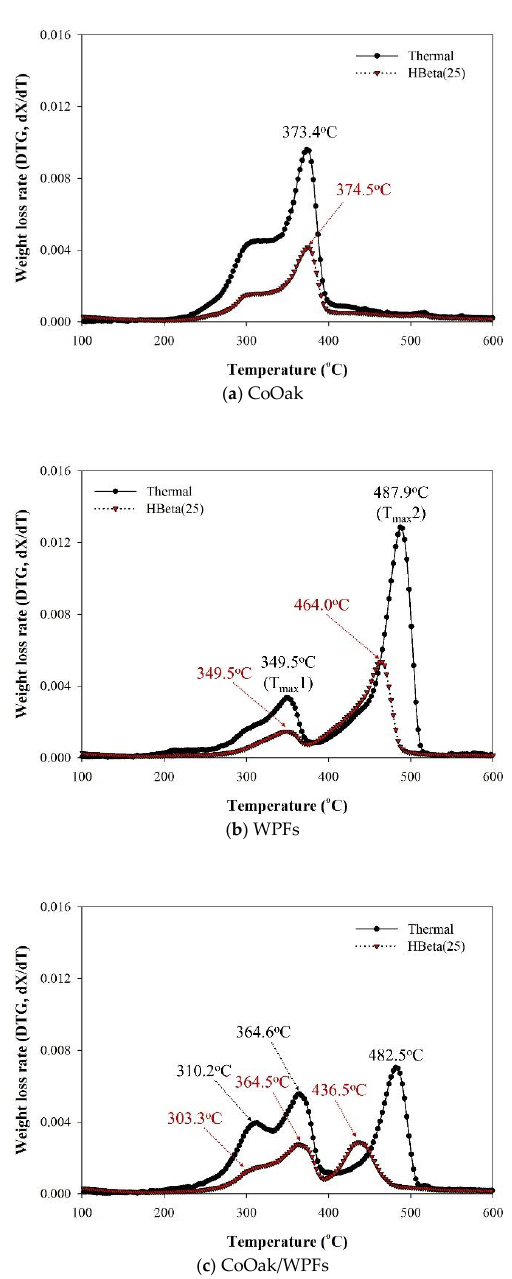
Figure 1. DTG curves obtained from thermal and catalytic pyrolysis of ( a ) CoOak; ( b ) WPFs; and ( c ) CoOak/WPFs over